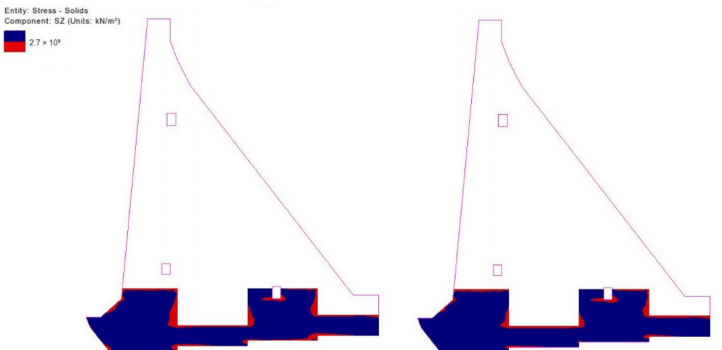
Figure 27. Zones in which the concrete tensile resistance is exceeded (red) in the mid-plane of the monolith 20 m long ( left ) and 15 m ( right ) for the 84th day from the beginning of construction (10th of January of the second year).